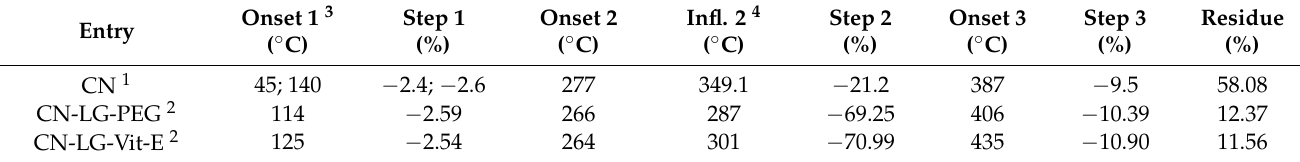
Table 1. Thermogravimetric data related to CN, CN-LG and CN-LG-Vit-E (Vitamin E).